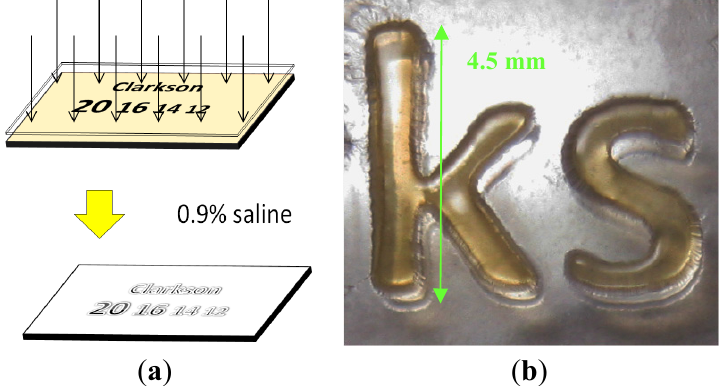
Figure 2. ( a ) Schematic representation of photochemical patterning of iron(III) cross-linked alginate hydrogel containing sodium lactate; ( b ) enlarged image of the patterned